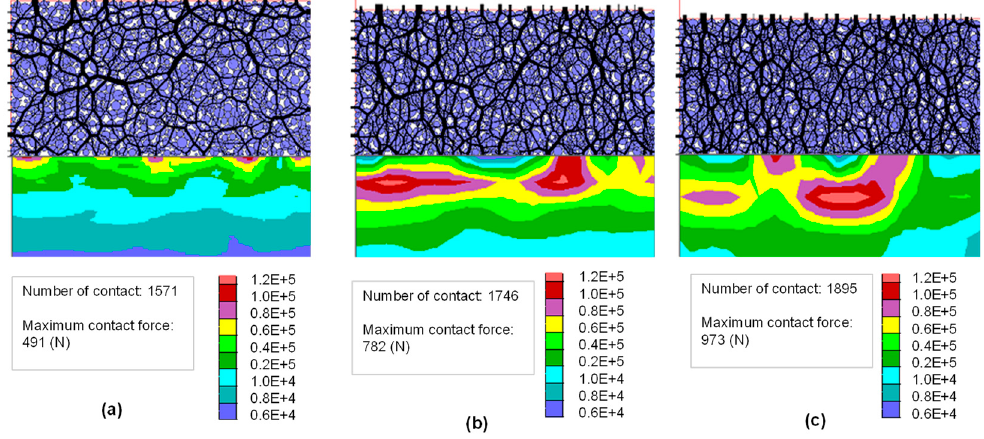
Figure 19. Distribution of contact forces and vertical stress contour developed in discrete and continuum media at varying load cycles; ( a ) N = 10 cycles; ( b ) N = 1000 cycles; and ( c ) N = 5000 (modified after Ngo et al. [62]—with permission from ASCE).